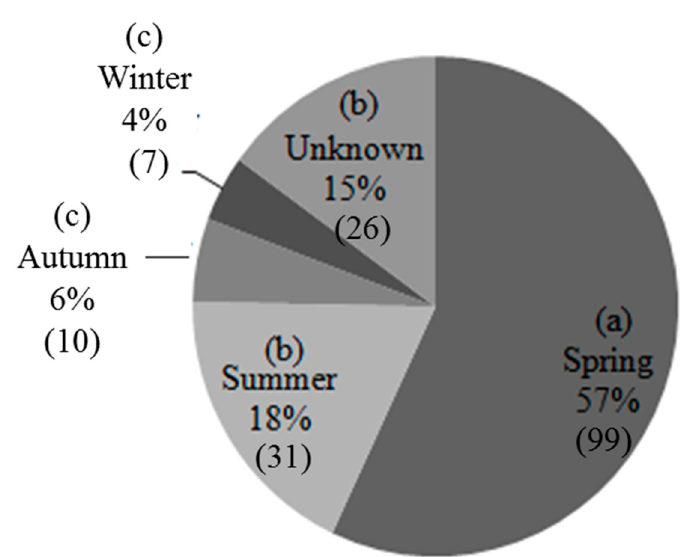
Figure 3. Seasonal incidences of livestock depredation by north China leopards in and around the Tieqiaoshan Provincial Nature Reserve. The percent values with different letters in brackets represent significant differences at p = 0.016 level. Numbers in brackets next to % value represent the number of livestock killed in that season.